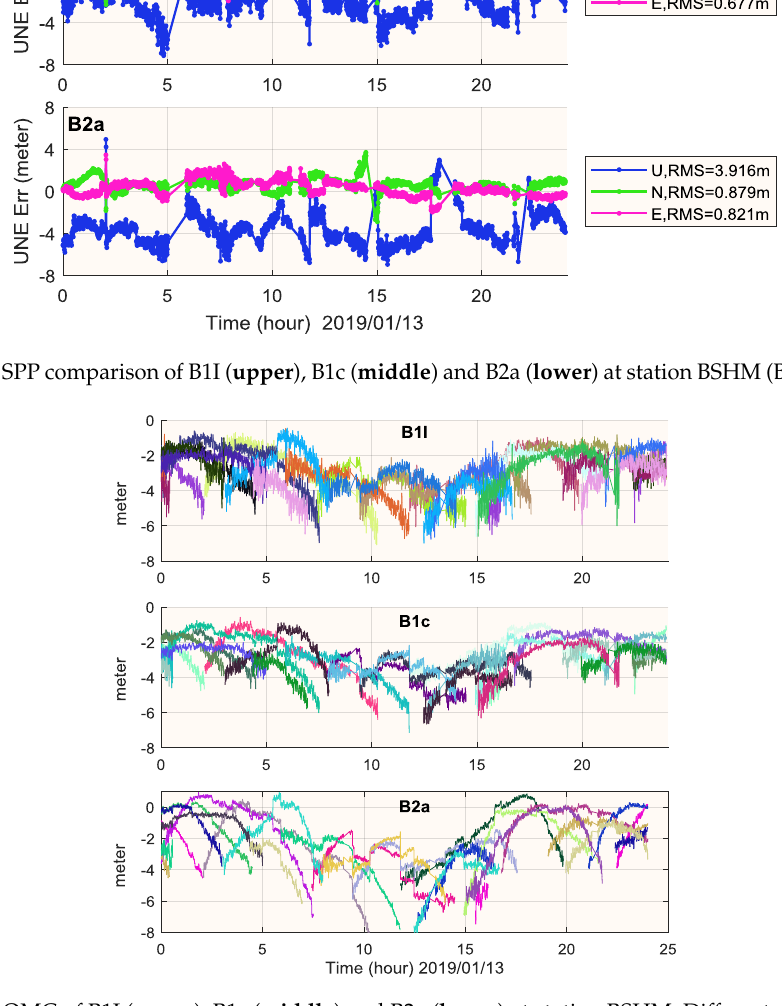
Figure 13. OMC of B1I ( upper ), B1c ( middle ) and B2a ( lower ) at station BSHM. Di ff erent color means di ff erent satellite in each subplot. OMC may contain residual error of receiver clock, but it is the same for each satellite at the same epoch.